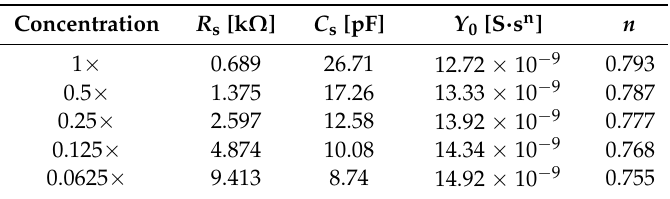
Table 1. Extracted resistance ( R s ), capacitance ( C s ), and parameters ( Y 0 and n ) of CPE through curve fitting with the experimental